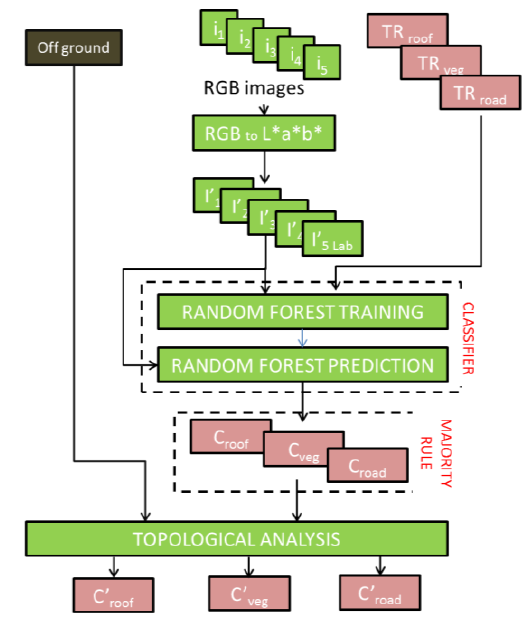
Figure 4: Scheme of the classification methodology